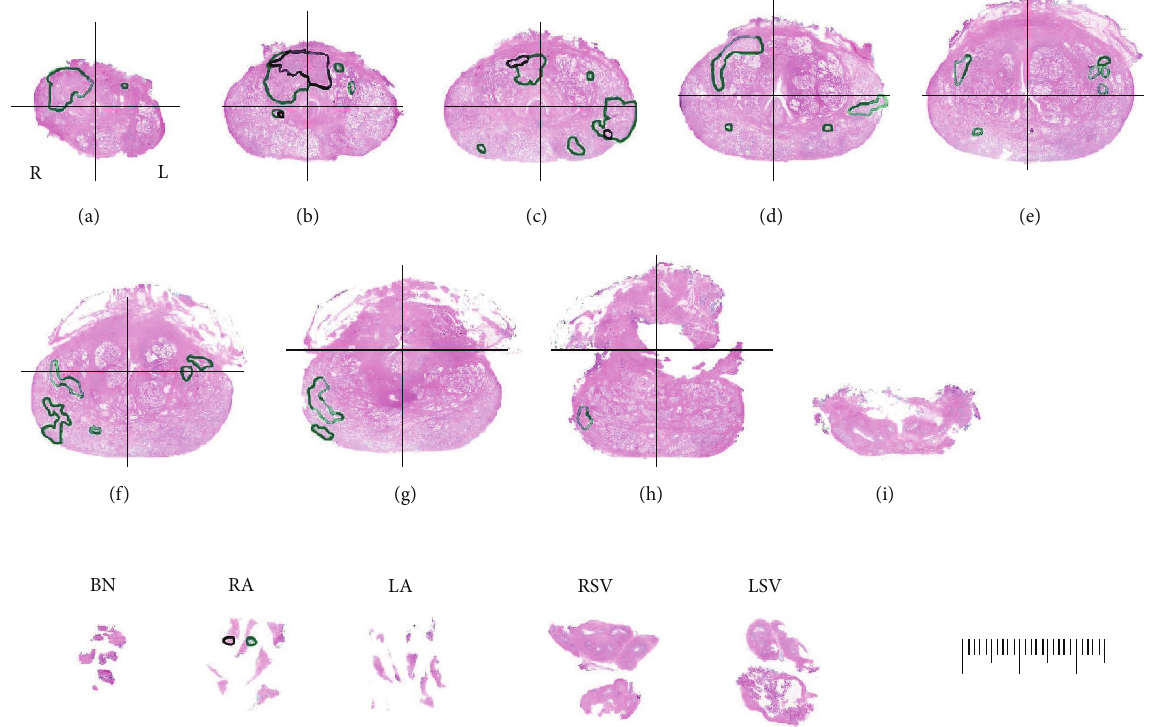
Figure 1: Representative example of study tumor map from whole-mount slides obtained in 3 mm sections. Colored ink outlines tumor location (green = Gleason pattern 3, black = Gleason pattern 4 or